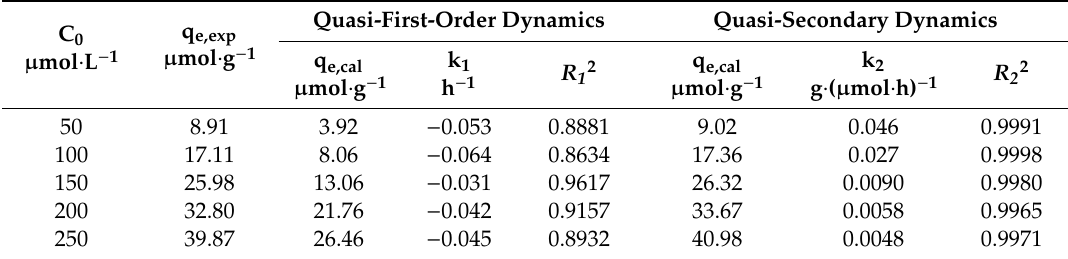
Table 2. Fitting parameters of quasi-first-order and quasi-second-order kinetic models under di ff erent mixed solution concentrations.